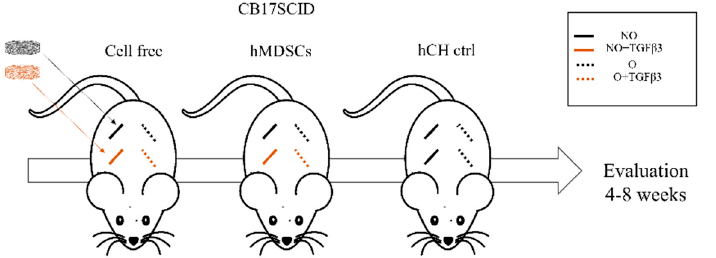
Figure 1. Experimental in vivo mouse model. Different scaffolds—NO and O with or without a growth factor (TGF β -3) and with or without hMDSCs, and hCH as control were implanted into CB17SCID mice, and mice were followed up for 4 and 8 weeks. hMDSCs—human-muscle-derived stem cells; hCH—human chondrocytes; ctrl—control; NO—not ozonated; NO- TGF β -3—not ozonated, treated with TGF β -3; O—ozonated; O- TGF β -3—ozonated, treated with TGF β -3; TGF β -3— transforming growth factor beta-3.